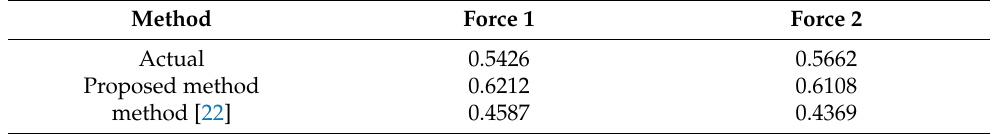
Figure 6. Comparison of estimated results and actual results: ( a ) force 1; ( b ) force 2. Table 1. Estimated RMS